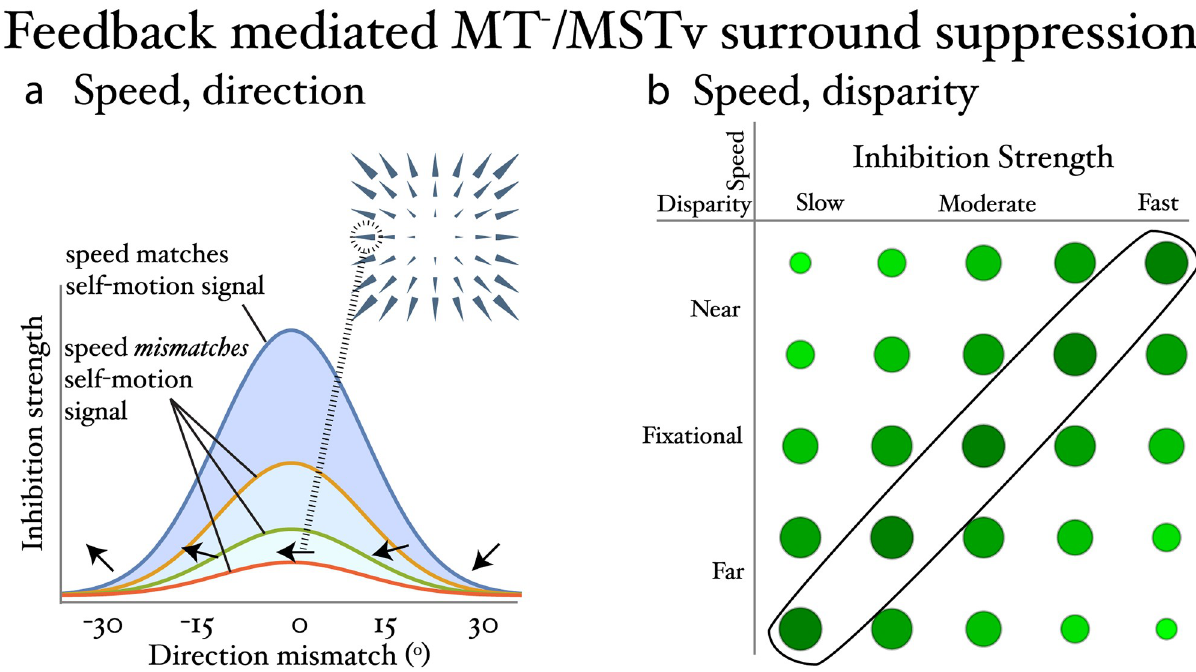
Fig 3. Overview of suppressive feedback mechanism. MT − and MSTv units are inhibited depending on how their tuning properties relate to the corresponding local subregion of the most active MSTd unit’s RF. (a) The pattern selectivity of the MSTd unit is indicated on the top-right and the RF of some MT units are shown in left superimposed circle. Highest peak curve in plot shows that MT suppression is greatest when the MT direction tuning locally matches (leftward; 0˚ mismatch) the MSTd RF; units with mismatching direction tuning receive progressively less inhibition. Other curves show that inhibition drops off as speed tuning locally differs from the MSTd RF. (b) MT − and MSTv units receive the most inhibition when they match the congruent speed-disparity tuning of the MSTd unit (circled diagonal). For example, among units with RFs near the FOE, those tuned to slow and far receive more inhibition than those tuned to slow and